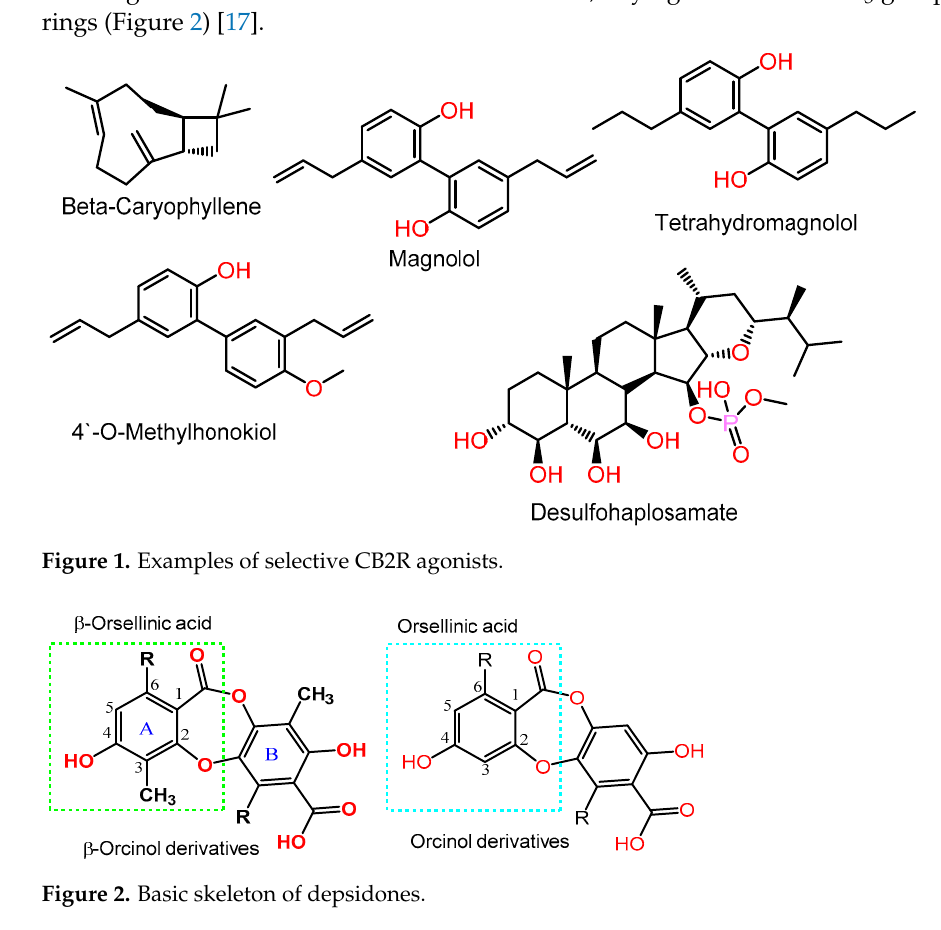
Figure 2. Basic skeleton of depsidones.